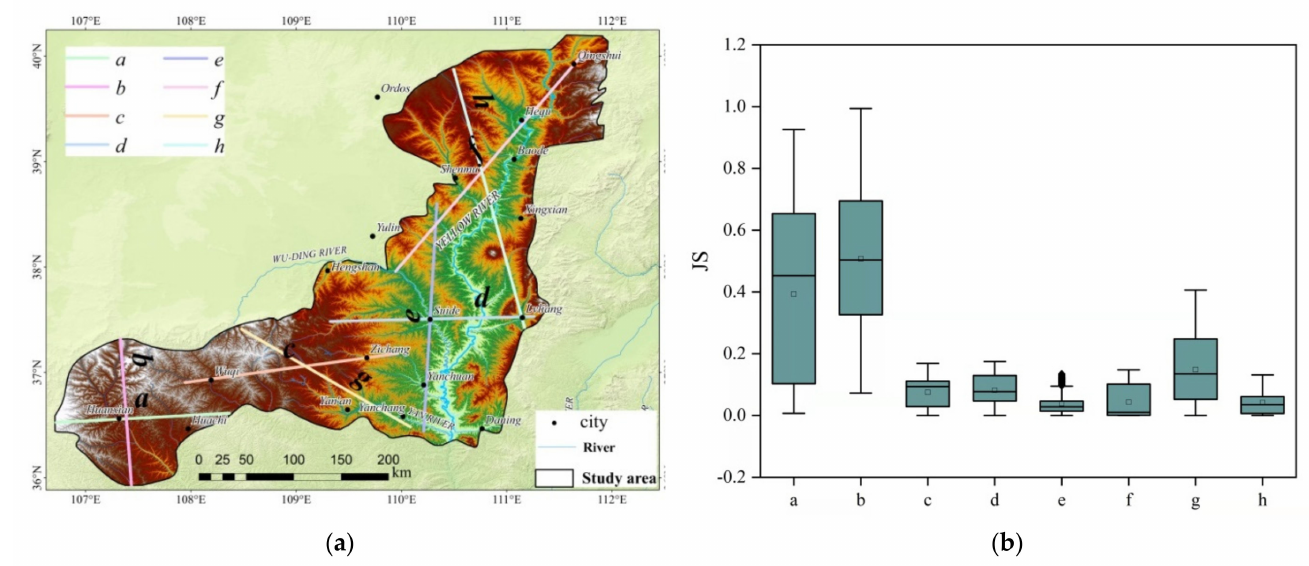
Figure 12. ( a ) Distribution of the 8 terrain profiles in the study area; ( b ) variation of JS divergence on 8 pairs of terrain